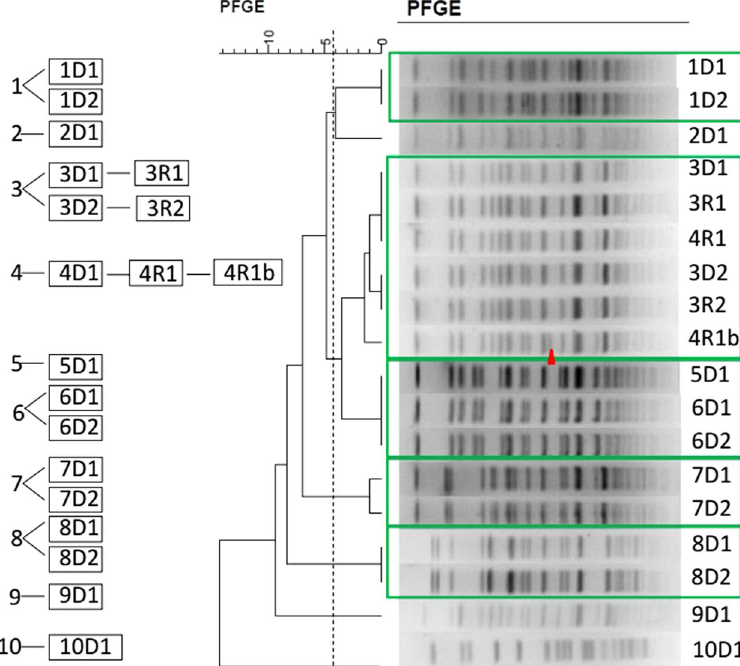
Figure 1. PFGE profiles of ApaI-digested DNA (all of the DNA) from 18 A . baumannii isolates. PFGE bands of the 18 A. baumannii isolates.